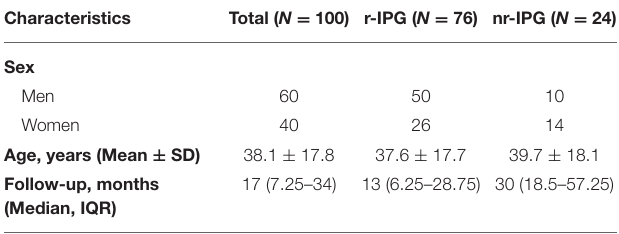
TABLE 1 | Demographic data.